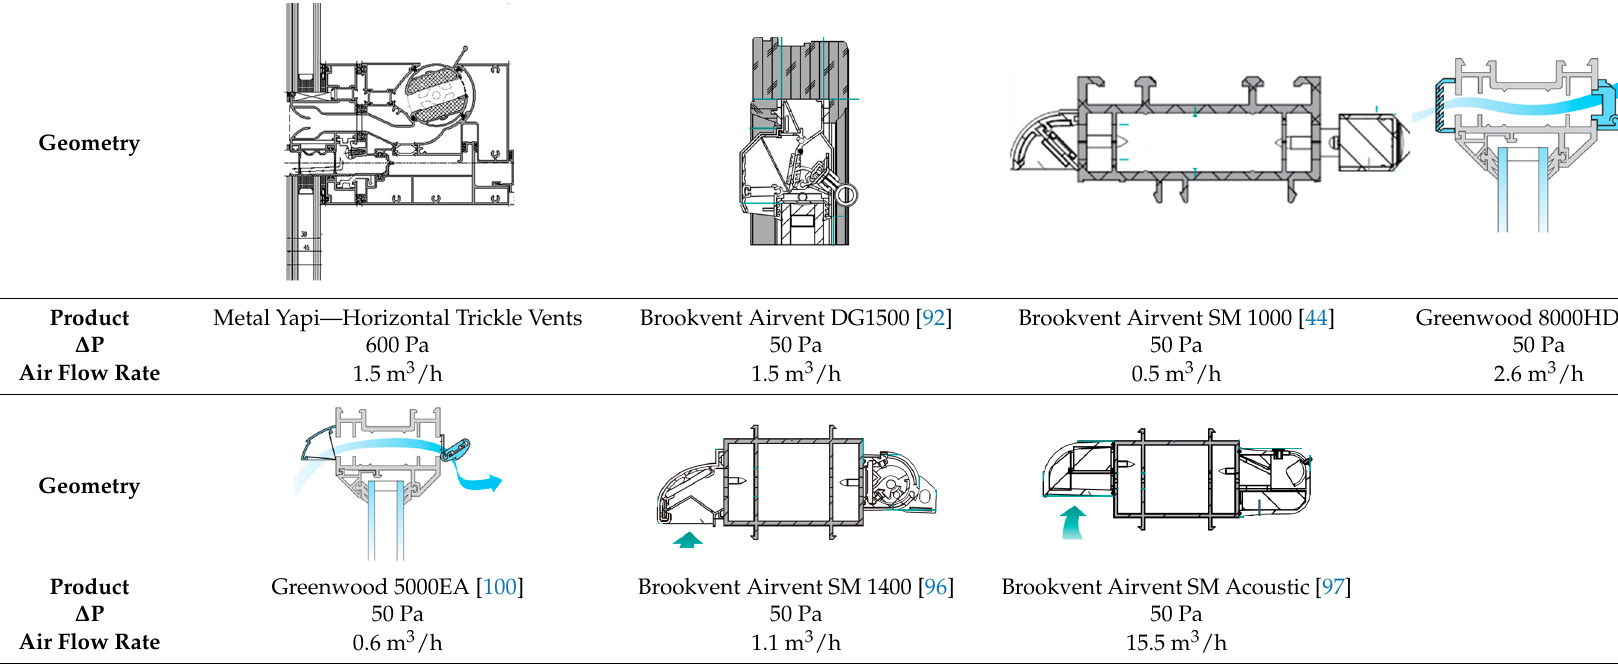
Table 11. Various Trickle Vent products and their air permeability rates in different pressure differences.